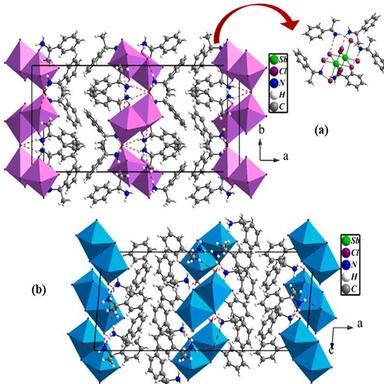
(a) Crystal packing of (C8H12N)42 compound in the (ab) plane. The dotted lines indicate hydrogen bonds with a partial view of the N–H⋯Cl and hydrogen bonds (represented by dashed lines) (b) other Projection of the crystal structure on the (ac) planes.